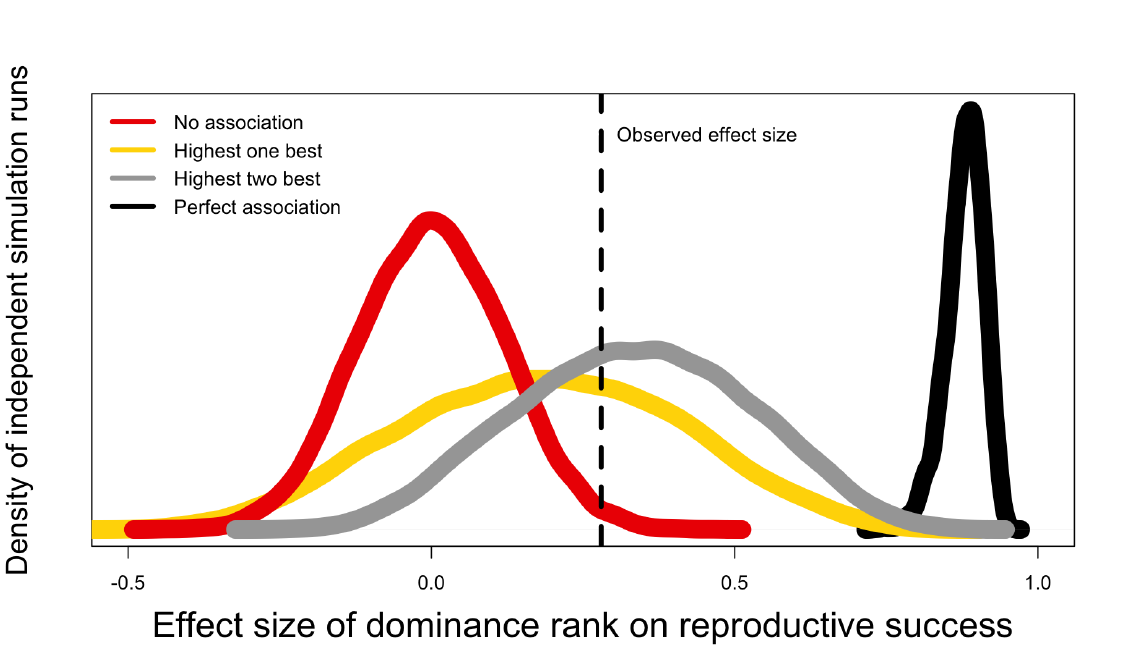
Figure 11. The average effect size of dominance rank on female reproductive success we observe in our sample (0.28; dotted vertical line) is in between the effect sizes expected for social groups in which there is either no (grey line) or a perfect association (black line) between each rank and the reproductive success of females. The observed value is close to a situation in which the two highest ranking females (red line) or only the highest ranking female (yellow line) always have the highest success in a group of twelve females. Lines represent the densities of 10,000 simulated samples showing the respective effect size for each of the four